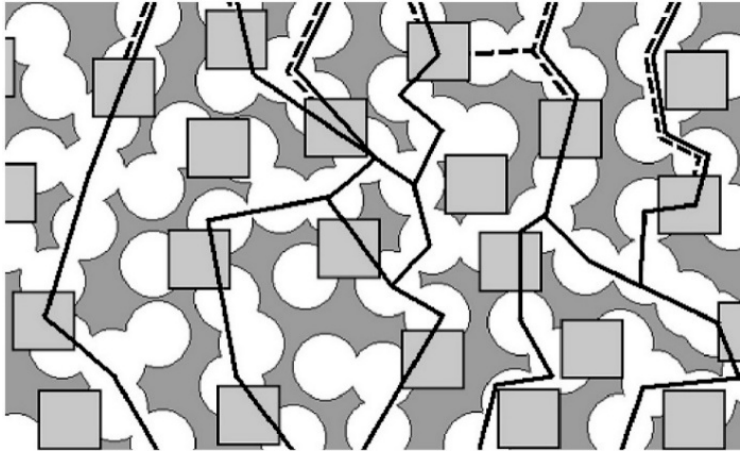
Figure 2. Separation schematic for the permeation of two species from the top to the bottom of the Zeo TIPS membrane. The dashed lines represent the path of the larger component. The solid lines represent the path of the smaller component [72].